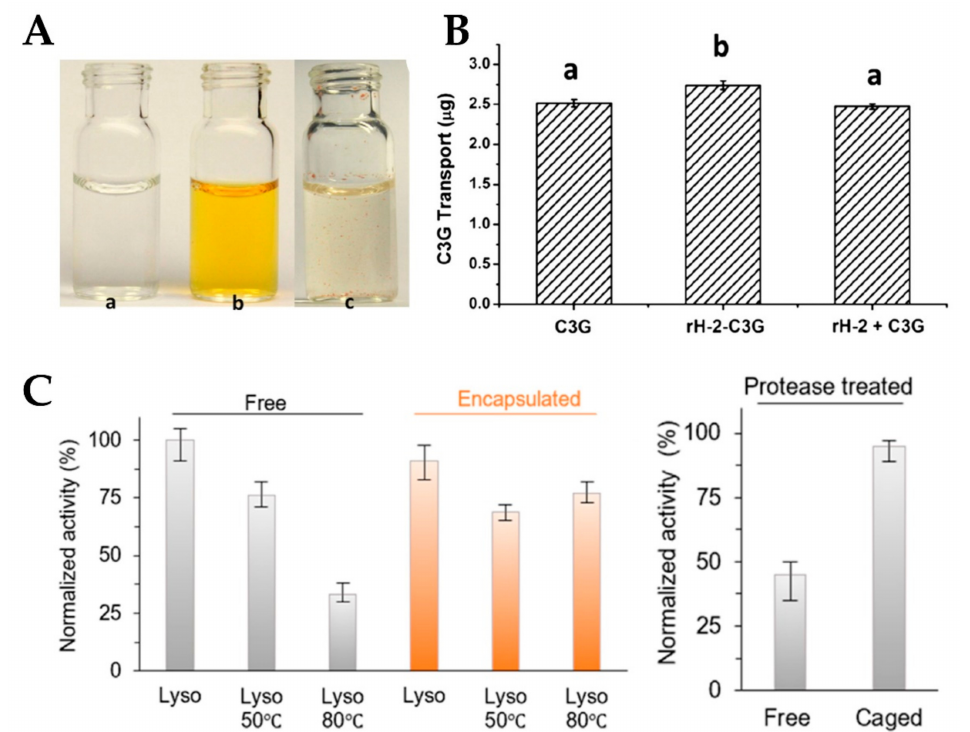
Figure 5. ( A ) Pictures of HuHF alone (a), HuHF-encapsulated curcumin (b), and free curcumin simply mixed with deionized water (c) (Reproduced with permission from [18], Food Res. Int. , 2014). ( B ) The amount of the transport of C3G to cell monolayer after 1 h incubation (Reproduced with permission from [14], Food Res. Int. , 2014). ( C ) E ff ect of heat and trypsin on the activity of encapsulated or free lysozyme (Reproduced with permission from [60], Nano Lett. ,